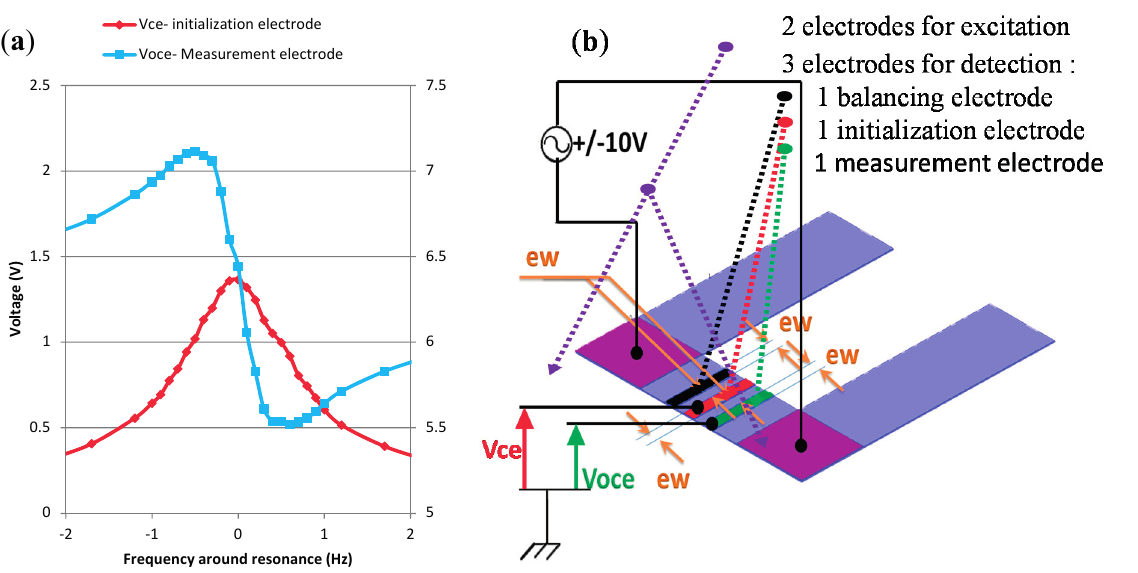
Figure 6. ( a ) Frequency analysis of voltage signals Vce and Voce; ( b ) Piezoelectric excitation and detection with three electrodes placed at regular intervals and centered on the coupling